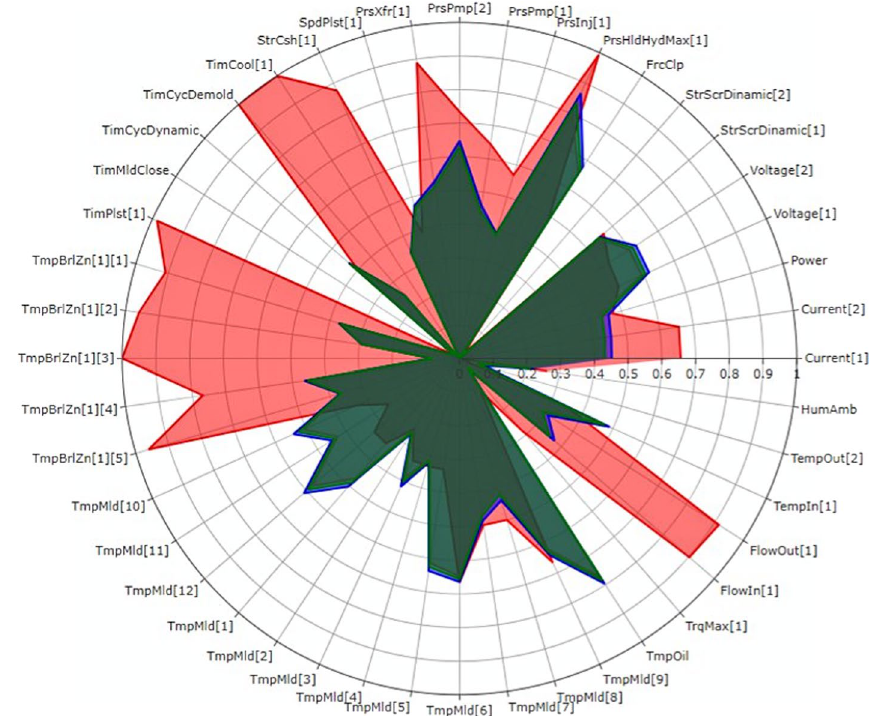
Fig. 12 The radar map compares the quality product with the abnormal product in terms of the process parameters. The scaled process parameters are placed around the circle. While the green area indicates the quality product, the red area shows the abnormal one. The abnormal product can be analyzed in detail using this radar map